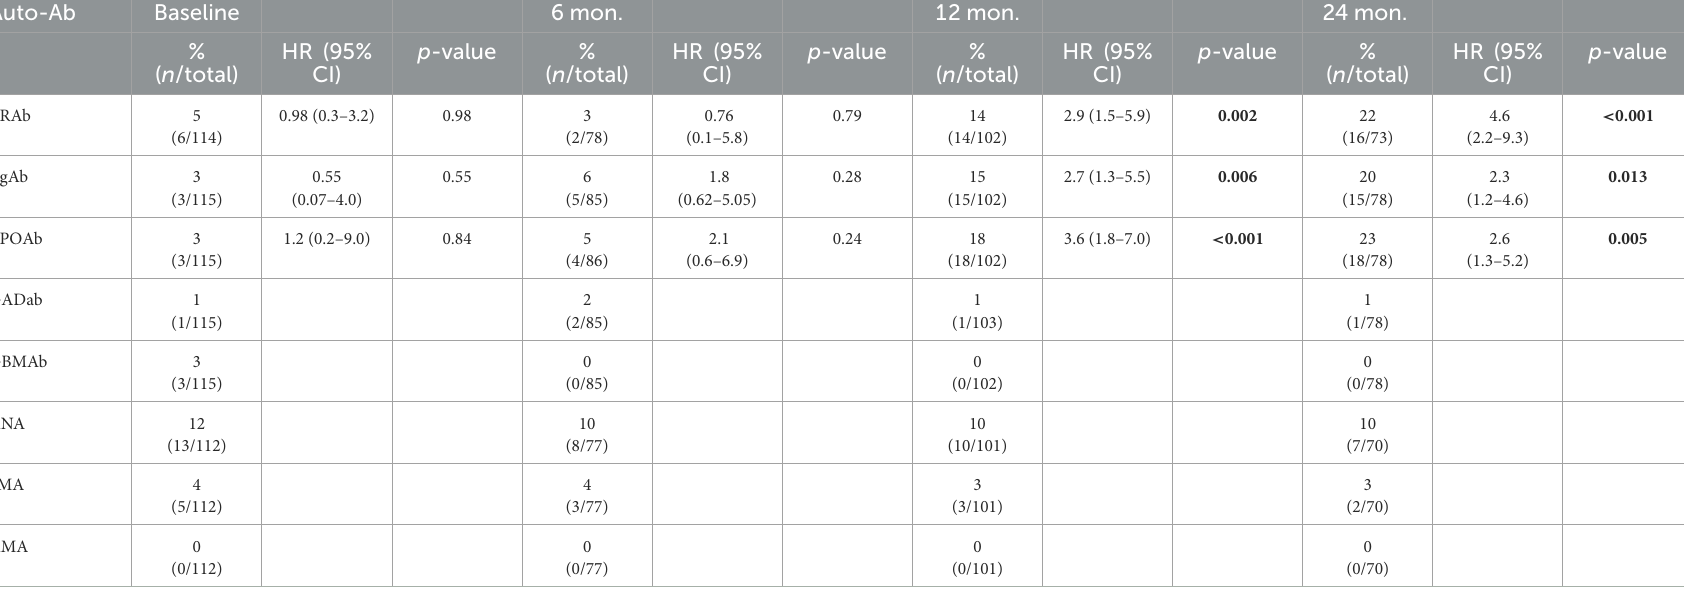
TABLE 2 Prevalence of auto-Abs and Cox proportional hazards for thyroid auto-Abs at the baseline and at 6, 12, and 24 months of follow-up.